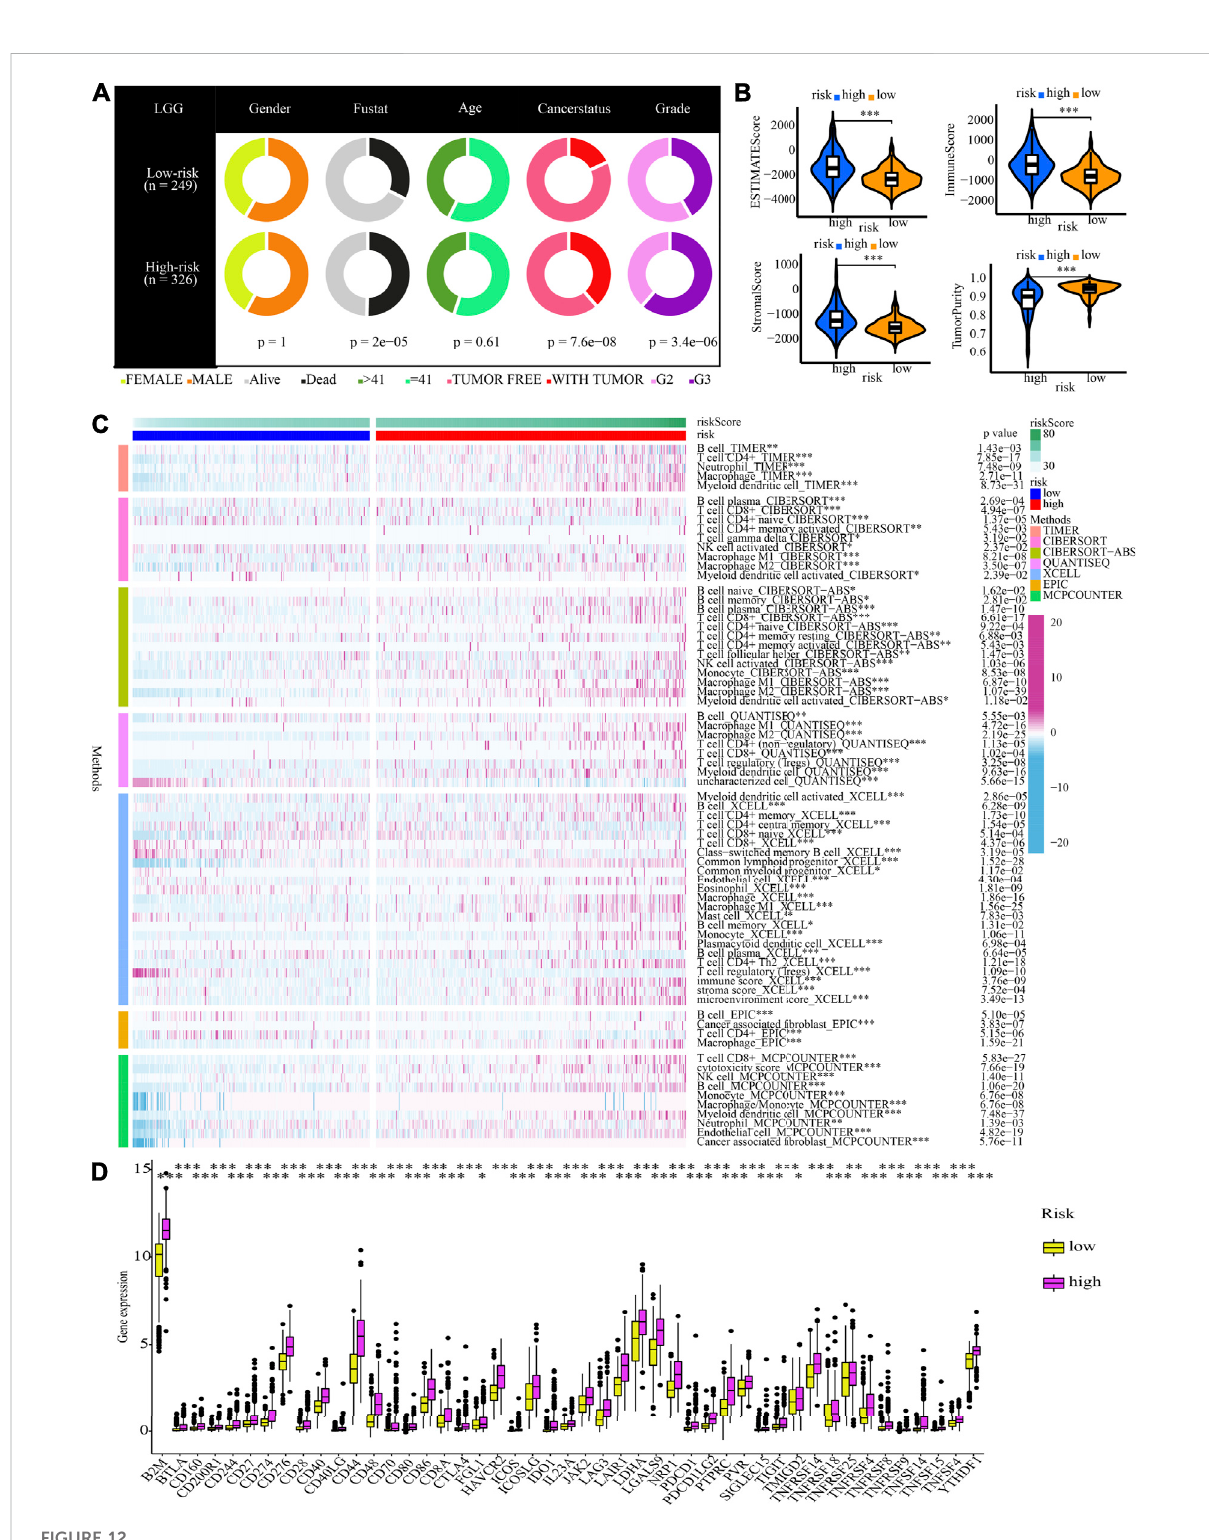
FIGURE 12 Clinicalcharacteristicsandimmunecharacteristicsinthevalidationcohort. (A) Analysisofthecompositionalvariationsbetweenlow-andhigh- risk groups in terms of clinical characteristics. (B) Comparative analysis of the TME components for low- and high-risk groups (C) The pattern of the distribution of immune cell in fi ltration in the validation cohort. (D) The expression pro fi les of ICGs in the validation